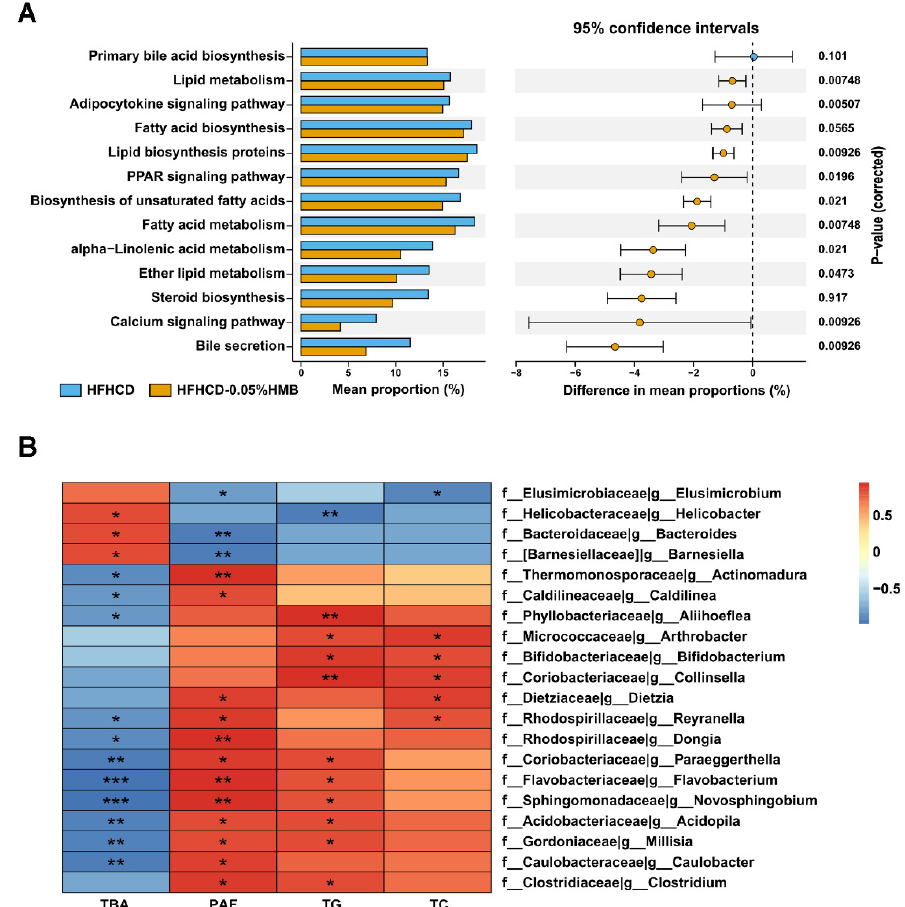
Figure 7. Effects of HMB on the function of gut microbiota in HFHCD–challenged layers. ( A ) KEGG functions of microbial communities in the HFHCD and HFHCD − 0.05% group. Only lipid metabolism–related pathways are shown. ( B ) Heat map of correlation analyses of lipid metabolism– related parameters and relative abundances of gut microbiota. Only the top 20 significant correlations are shown. * p < 0.05, ** p < 0.01, *** p < 0,001. Abbreviations: TBA, total bile acids; PAF, percentage of abdominal fat; TG, triglycerides; TC, total